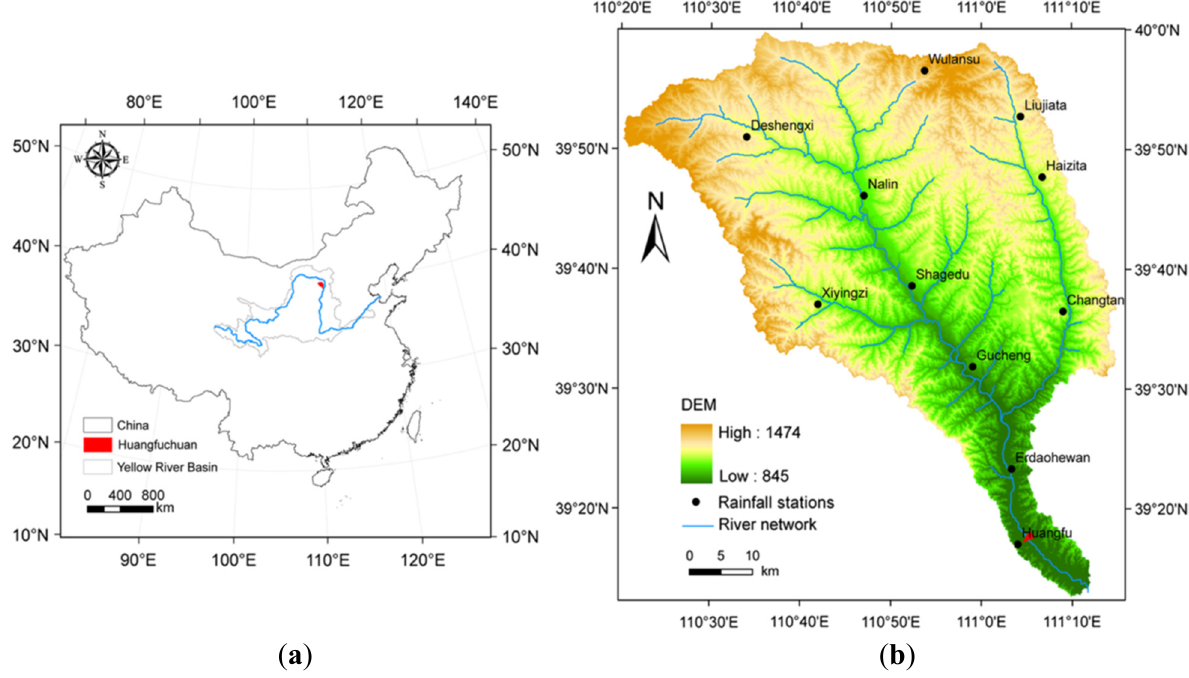
Figure 1. Location of Huangfuchuan catchment in China ( a ) and the watershed map showing the different rainfall stations ( b ); the red arrow on the watershed map showing the hydrological station of the watershed. Retrieved from